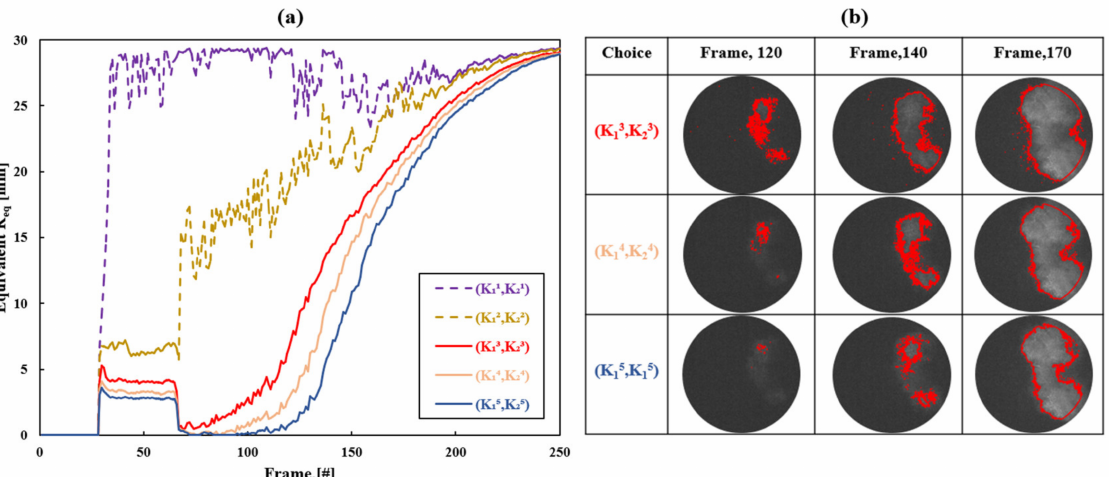
Figure A1. ( a ) Examples of R eq not suitable for reproducing the increasing trend of the flame radius during the development of the combustion process and R eq (solid lines) that may be considered potentially suitable for reproducing the same combustion physical phenomenon. ( b ) The figures on the right depict the contouring process, for the potentially right cases, applied to detect the capability of BR in reproducing the flame front of the original images. (K 13 , K 23 ) choice allows us to better reproduce the flame front, and therefore can be considered the best choice to